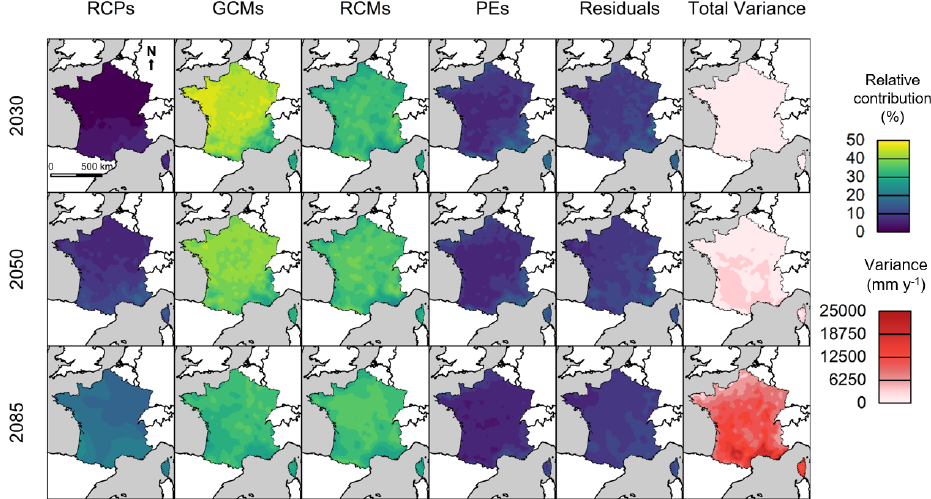
Figure 5. Uncertainty contribution of each impact modeling chain step to changes in PE across France for three different 30-year periods centered around 2030, 2050 and 2085. The contribution to the total uncertainty is presented in percent and is calculated with the QUALYPSO method.